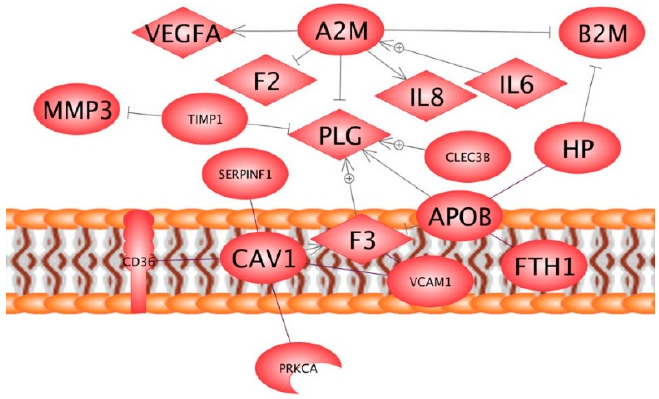
Figure 3. Network of interacting proteins: Lines show a kind of binding like it occurs e.g., when TIMP1 binds to the catalytic domain of MMP3 blocking its proteolytic site, arrows indicate regulation by direct interaction, i.e. , by binding which effects conformational or local changes of the target protein, (+) mean up-regulation. The protein names are arranged according to the cellular locations of proteins. Upper part: extracellular proteins, middle part: membrane proteins, lower part (PRKCA): intracellular proteins.